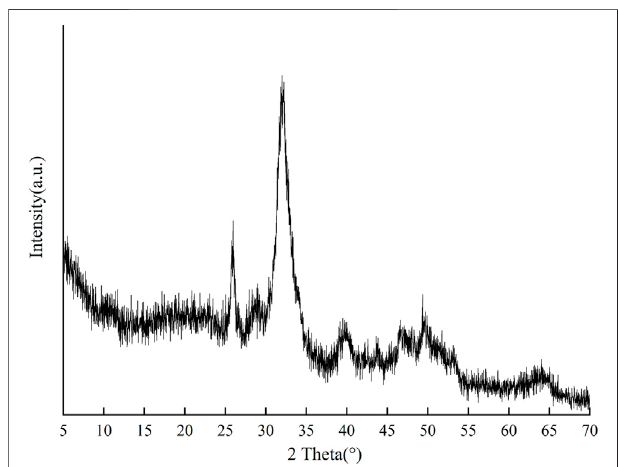
FIGURE 8 | XRD pattern of fresh